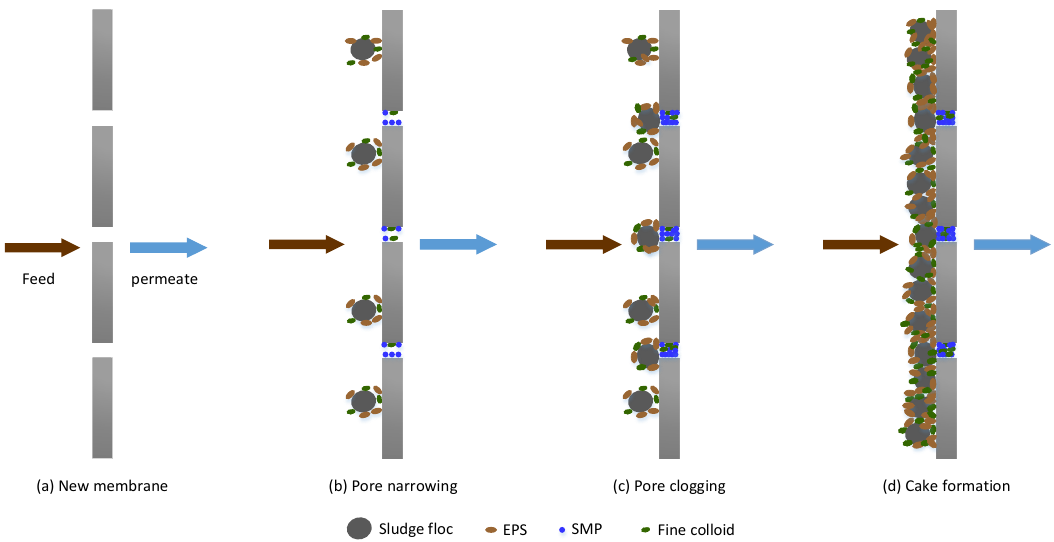
Figure 1. Mechanisms of membrane fouling in membrane bioreactors (MBR).